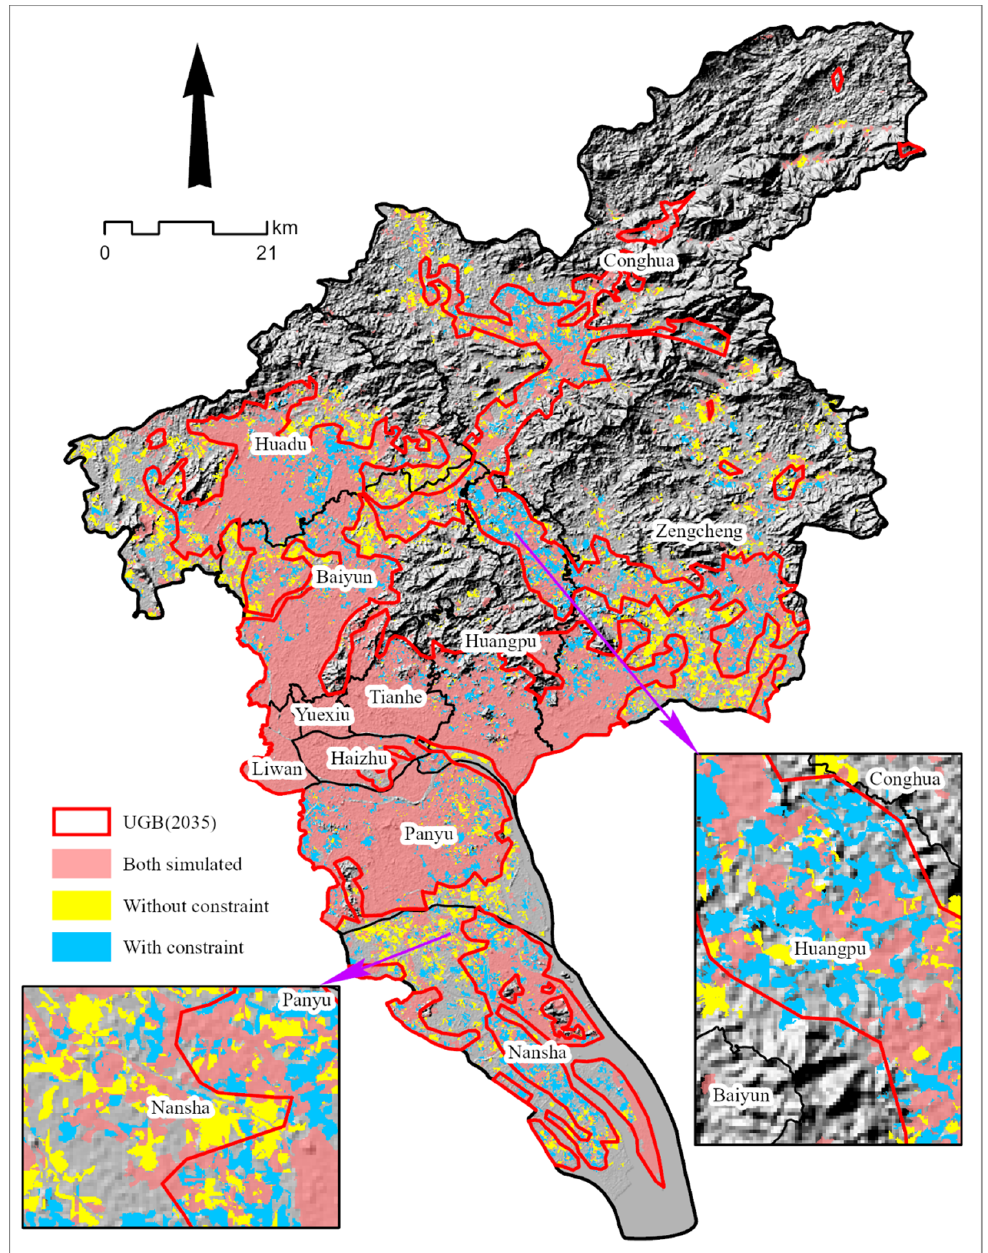
Figure 5. Comparison the simulation scenario with or without UGB.